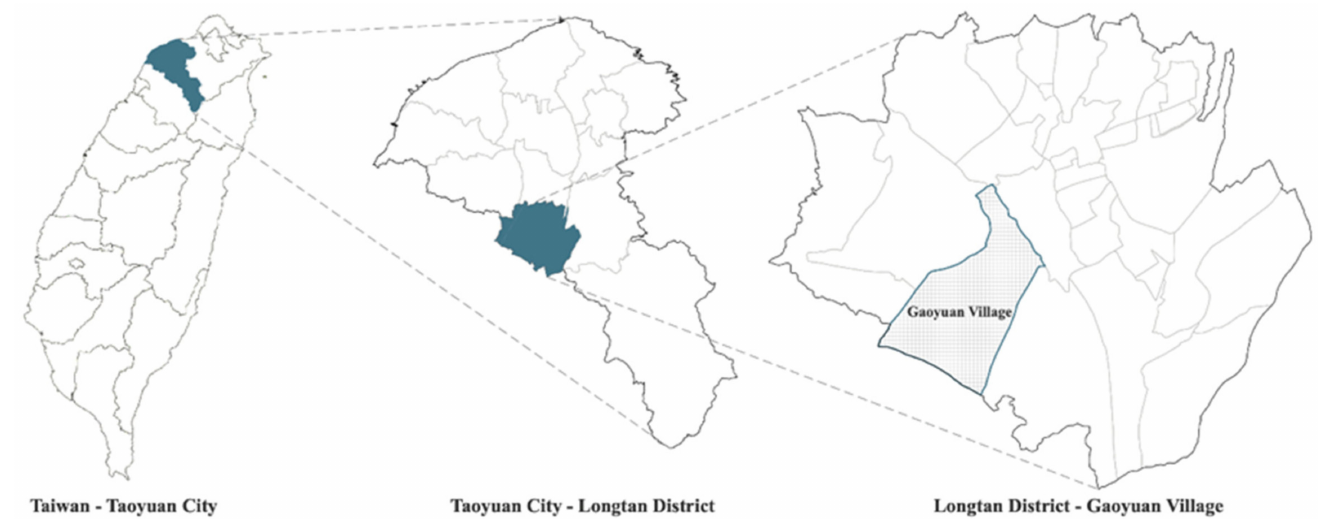
Figure 1. Location of Gaoyuan